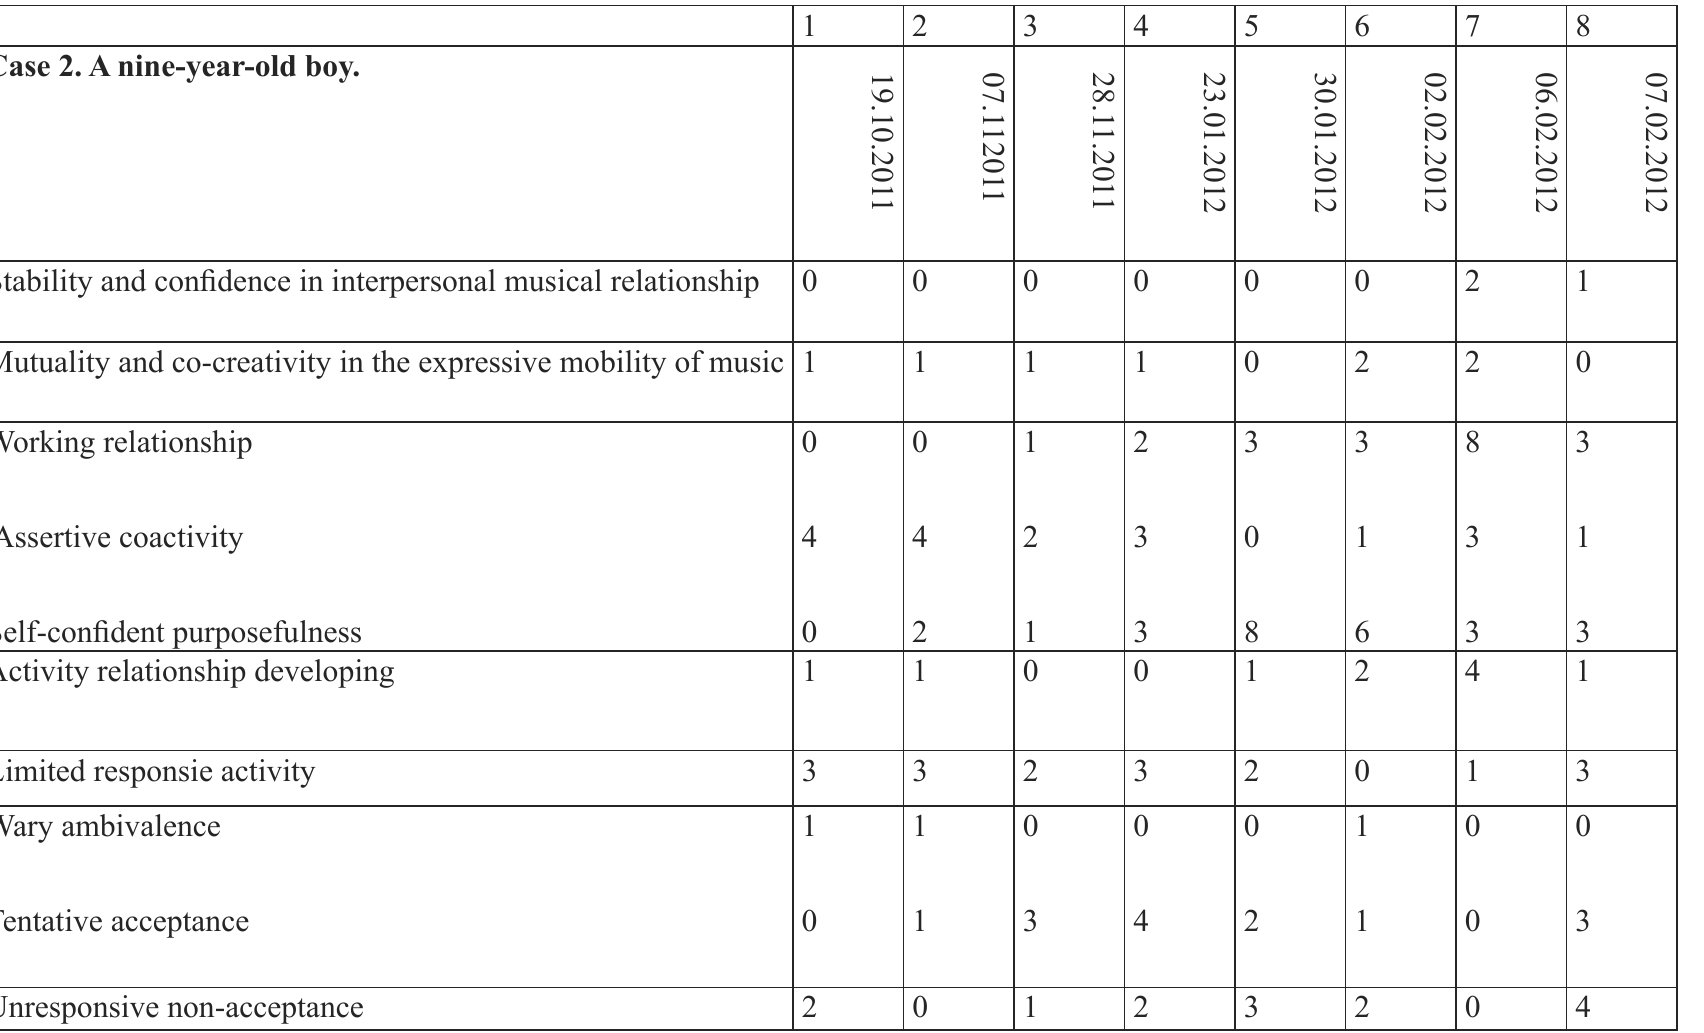
Tab. 2. Scale I Child – Therapist Relationship in Coactive Musical Experience Rating Form (a nine-year-old boy) Source: Own calculations and modi (cid:222) cations based on: P. Nordoff, C. Robbins (2007, p.